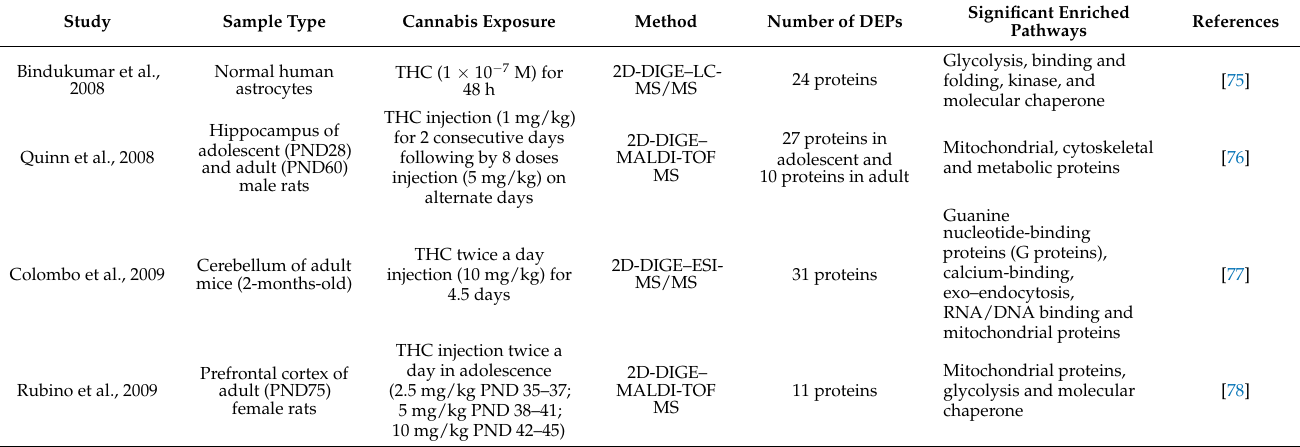
Table 1. Summary of proteomic studies on effects of cannabinoid exposure on the